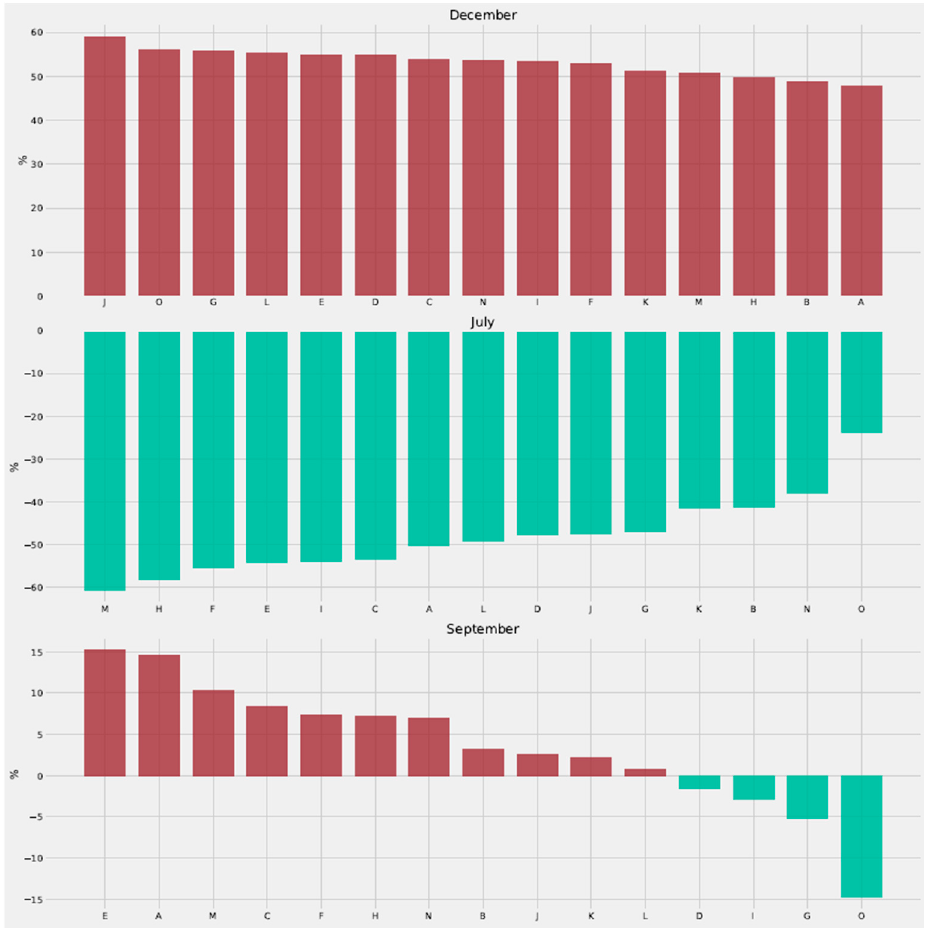
Figure 10. Percent differences in the monthly bills of the apartments under the proposed pricing model shown for three different months. December and July were selected to contrast the seasonal extremes, and September was selected as an intermediary case. Note that the graphs are organized in descending order and the x -axis therefore differs in each month.